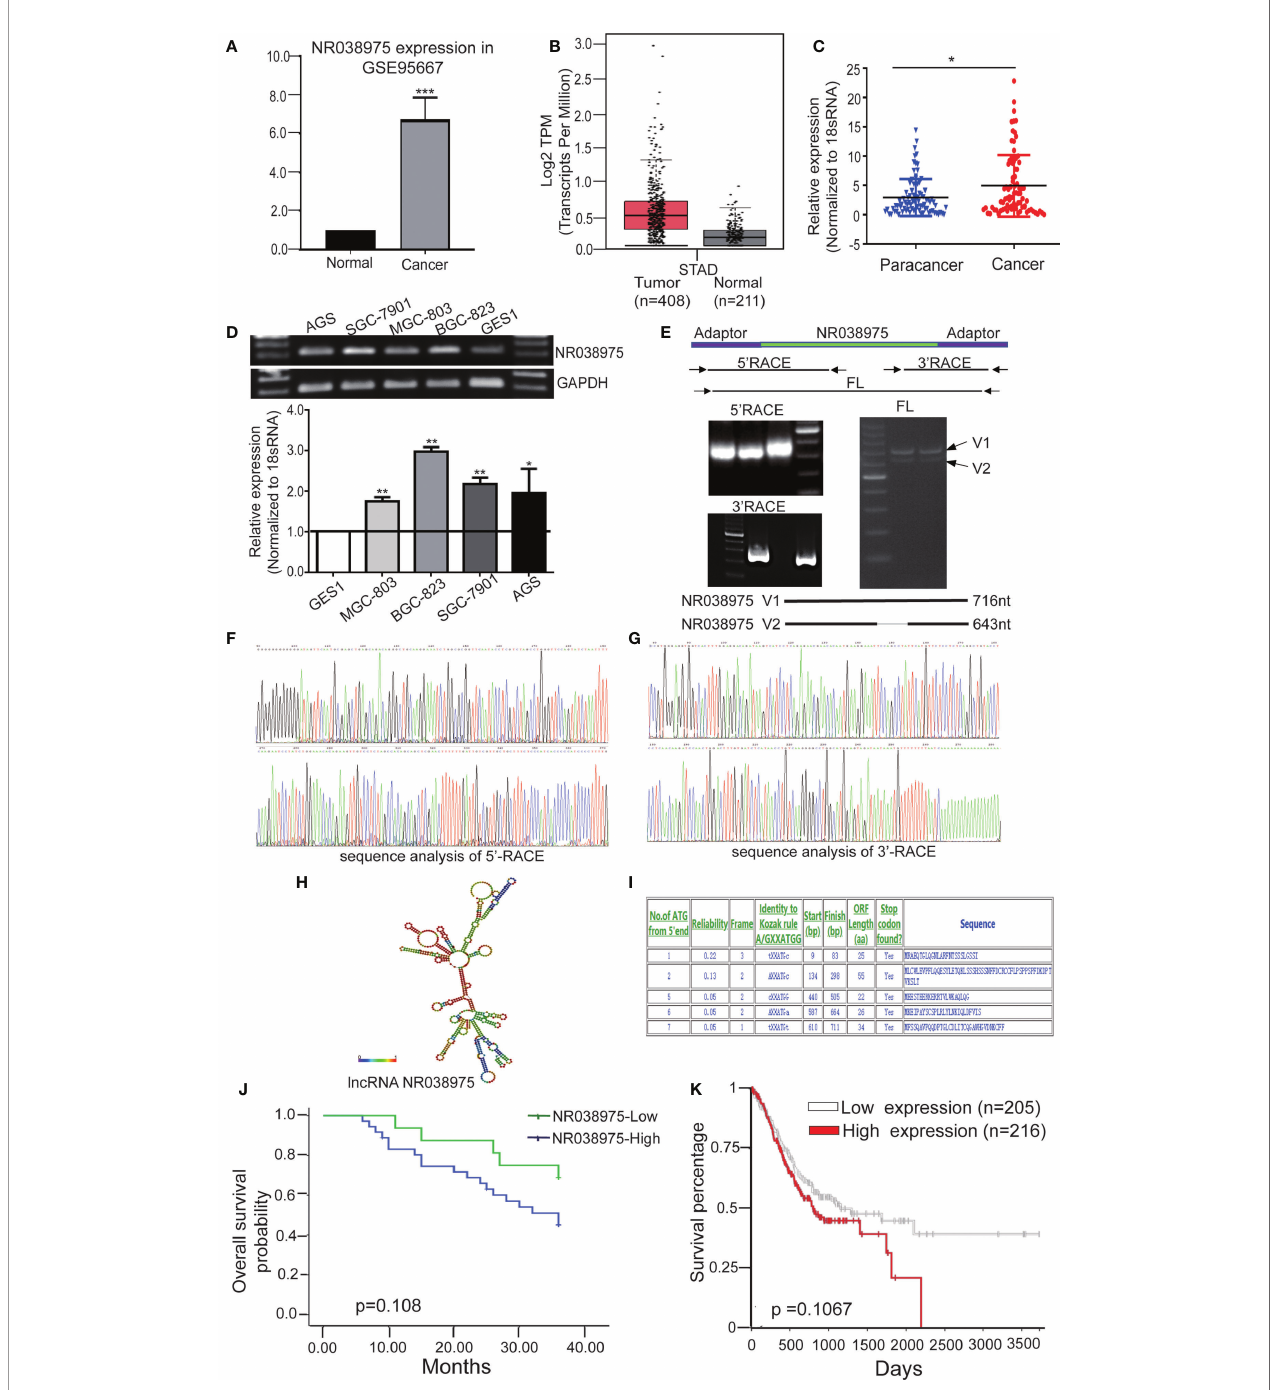
FIGURE 1 | Identi fi ed the novel gastric cancer-associated long noncoding RNA (lncRNA) NR038975. (A) The expression of lncRNA NR038975 in the lncRNA/ messenger RNA (mRNA) microarray analysis. (B) Relative expression of NR038975 in gastric cancer (GC) and normal tissues in Gene Expression Pro fi ling Interactive Analysis (GEPIA). (C) NR038975 expression was analyzed by qRT-PCR in GC samples and para-cancer tissues (n = 84). Statistical analysis was performed using t-test. The horizontal line indicates the median value. *p < 0.05. (D) NR038975 expression was analyzed by RT and qRT-PCR in GC cells and gastric normal epithelial cells. (E) Rapid ampli fi cation of cDNA ends (RACE) analysis of NR038975 transcripts resulted in two RNA variants (V1:716 bp and V2:643 bp), and full-length (FL) V1 and V2 were obtained by RT-PCR. (F) Sequence analysis of 5 ′ RACE of NR038975. (G) Sequence analysis of 3 ′ RACE of NR038975. (H) NR038975 folds in a stable stem-loop structure. (I) NR038975 lacks the potential to encode any recognizable protein domains. (J, K) The effect of SNHG5 expression level on clinical prognosis was analyzed by Kaplan – Meier survival analysis using patient overall survival (OS) data in our sample cohort (J) and TCGA data (K) . **p < 0.01, ***p <